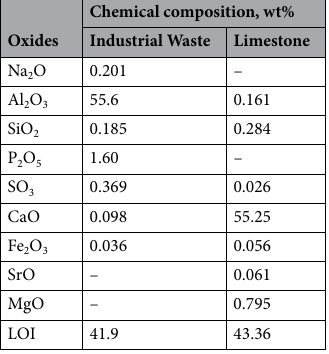
Table 1. Chemical analyses of starting materials.